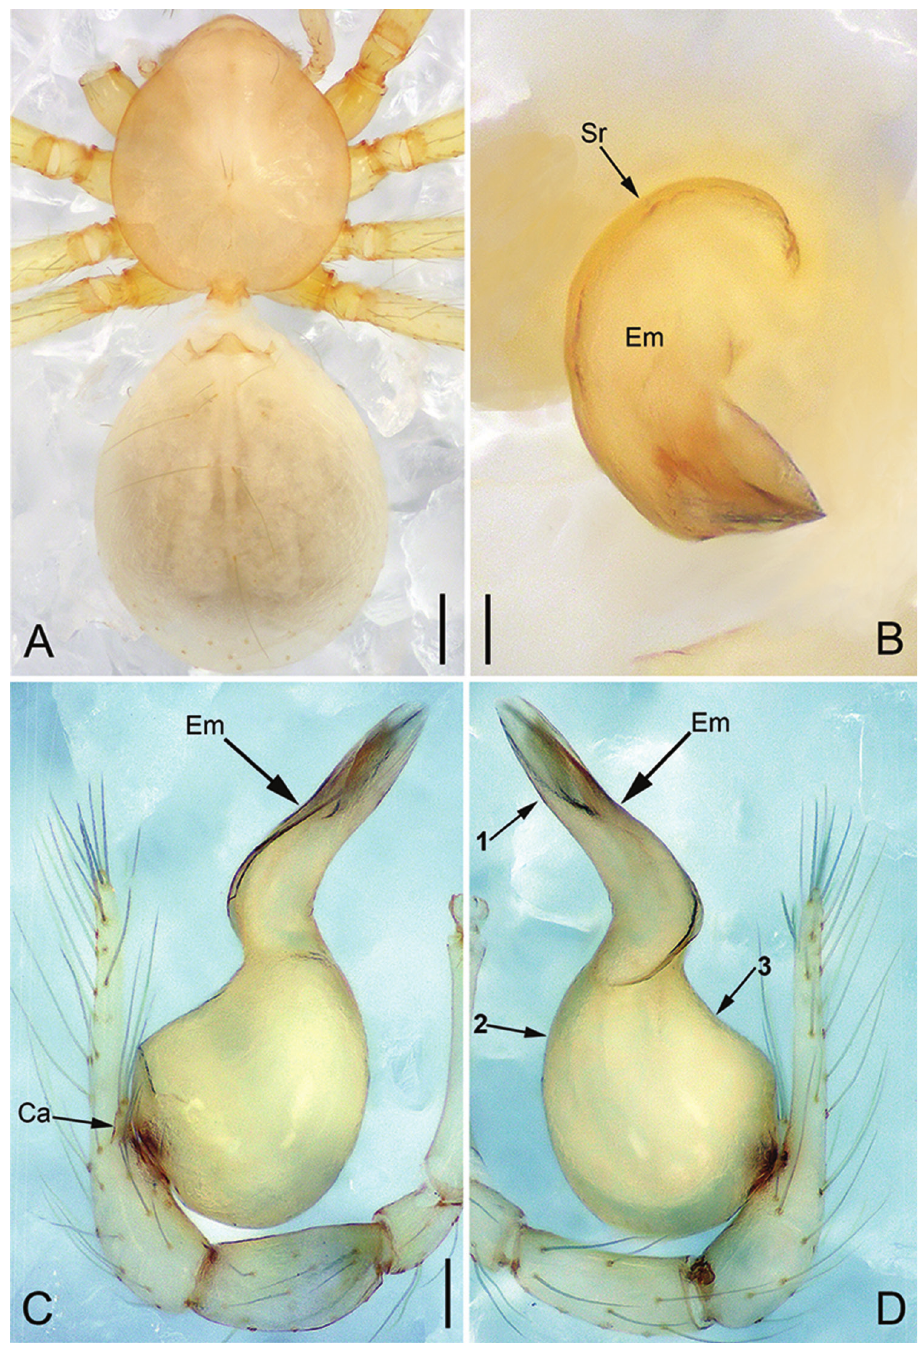
Figure 16. Pinelema strentarsi , male. A Habitus, dorsal view B Embolus, apical view C Palp, prolateral view D Palp, retrolateral view. Scale bars: 0.2 mm ( A ), 0.05 mm ( B ), 0.1 mm ( C–D